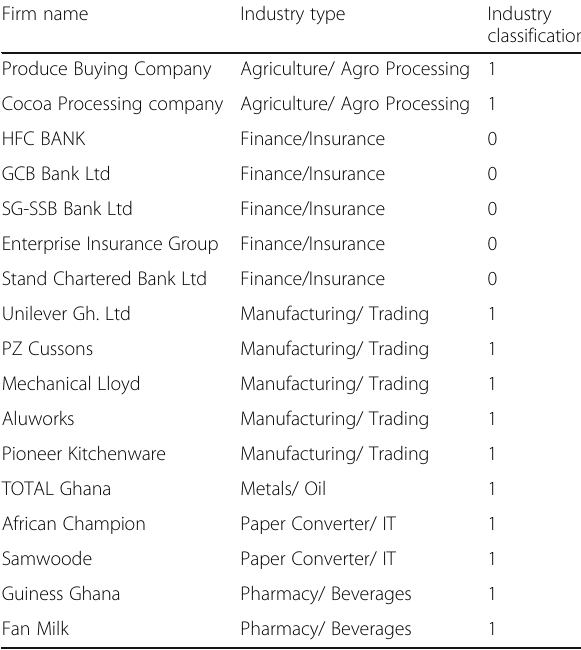
Table 4 Industry classification of firms in the